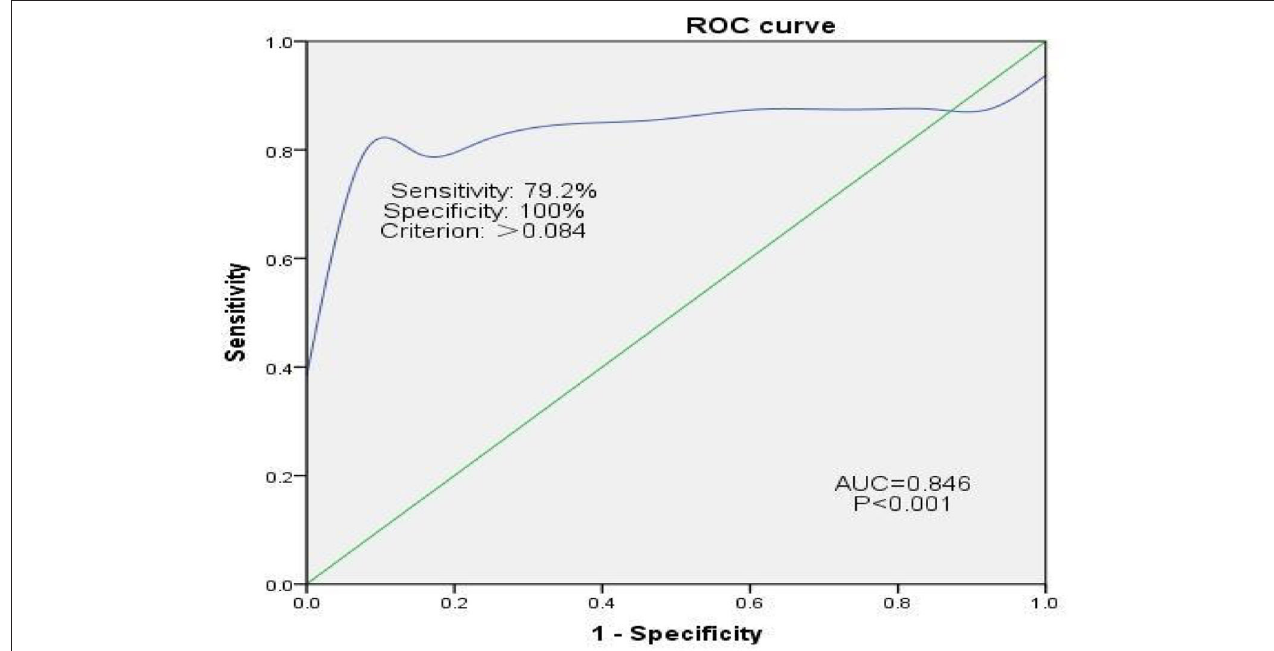
FIGURE 4 | ROC curve analysis assessing the efficacy of pulmonary function for diagnosing hemidiaphragmatic paralysis evidenced by diaphragm CMAP as an assessment of diaphragm function. CMAP, compound muscle action potential. Sensitivity = True Positives/(True Positives + False Negatives). False Positive Rate = 1 – Specificity, where specificity = True Negatives/(True Negatives + False